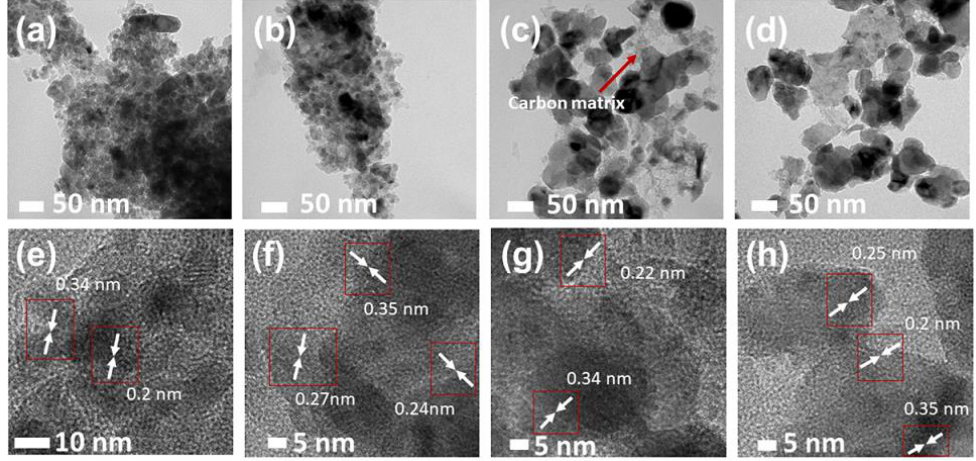
Figure 2. TEM images of ( a ) CIL (1:1), ( b ) CIL (3:4), ( c ) CIL (1:2) and ( d ) CIL (1:4). HRTEM images of ( e ) CIL (1:1), ( f ) CIL (3:4), ( g ) CIL (1:2) and ( h ) CIL (1:4).